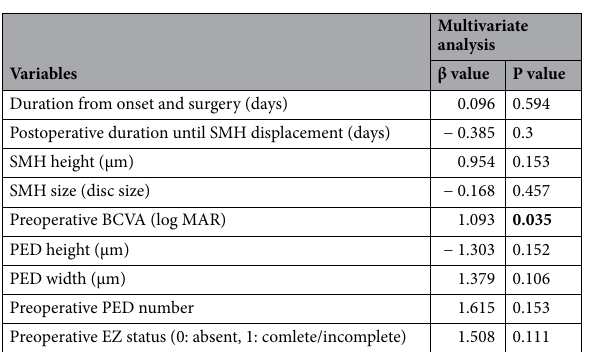
Table 5. Preoperative factors affecting postoperative visual acuity at 3 months. Significant values are given in